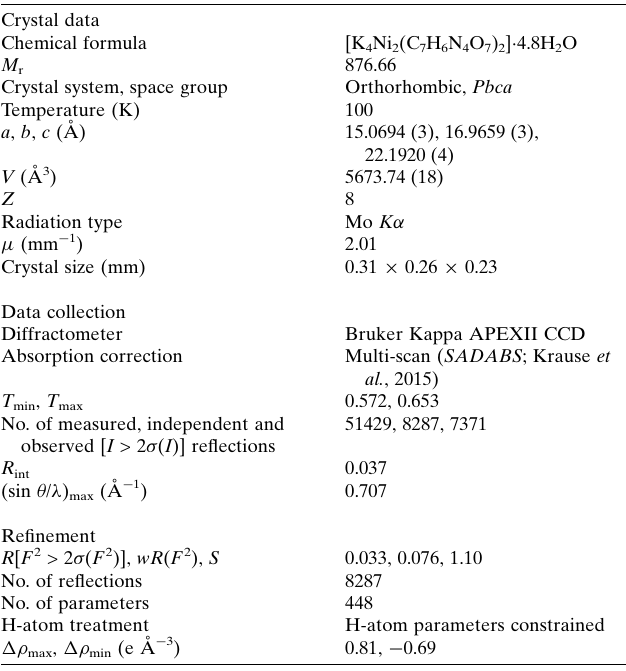
Crystal data Chemical